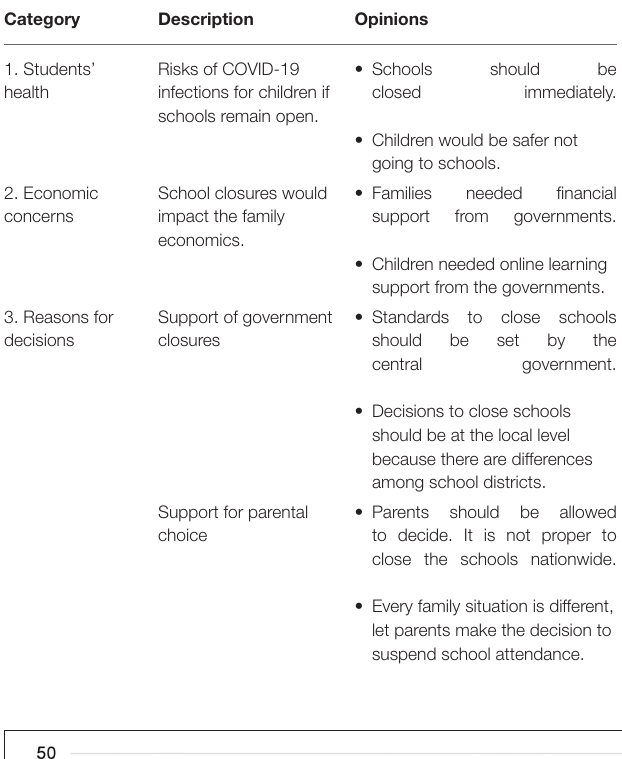
TABLE 3 | Summary of feedback: categories, description, and opinions. Category